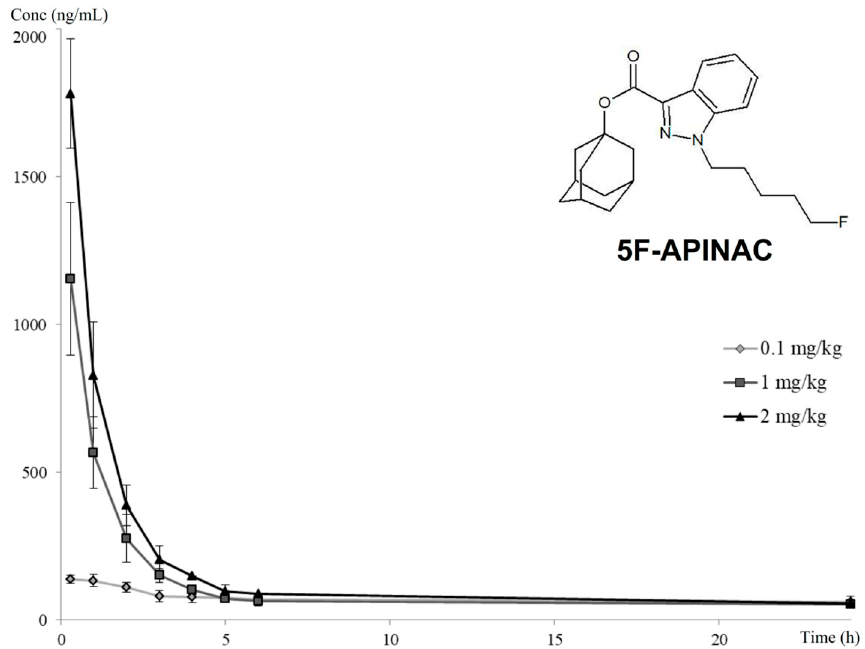
Figure 1. Pharmacokinetics profile of 5F-APINAC after the intravenous administration of 0.1, 1 and 2-mg/kg dosages in rabbit plasma. Blood samples were taken at 20 min and at 1, 2, 3, 4, 5, 6 and 24 h after the drug administration. Table 2. Summary of the main findings for the targeted metabolites associated with neurotransmission.